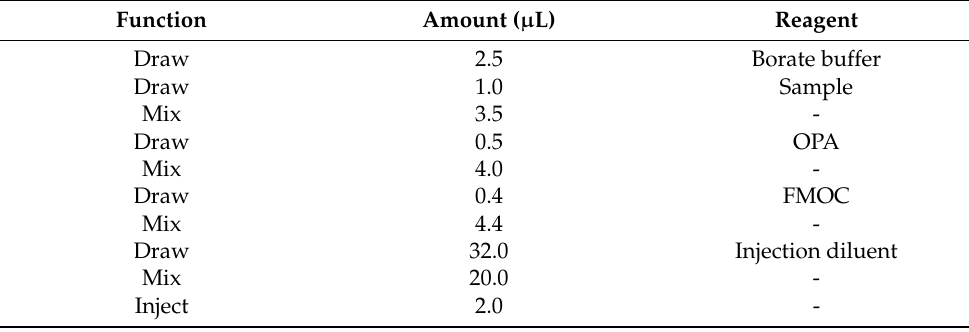
Table 1. The injection program for online derivatization of amino